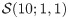
Top row shows the mutual information for different strategies of assigning ten bits into multiple consecutive samples for single sensors.The black solid lines correspond to mutual information with knowledge of the temporal sequence in which samples occur. The dashed black lines correspond to mutual information where the temporal sequence is ignored. The blue and green shaded regions correspond to information for the jittered locations of the narrow- and wide grid. Second row (A2-C2) shows the entropy for the corresponding strategies. The gray lines indicate the entropy of the incompressible odor measurements (S(10;1,1)). Full blue and green circles represent the entropy of the measurements at the narrow and wide grid locations. Hollow circles correspond to the measured sequence where the temporal sequence is ignored.